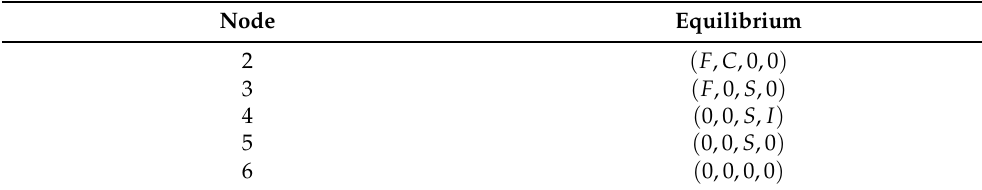
Table 1. Pairings of the states in the network with the ecosystem equilibria.